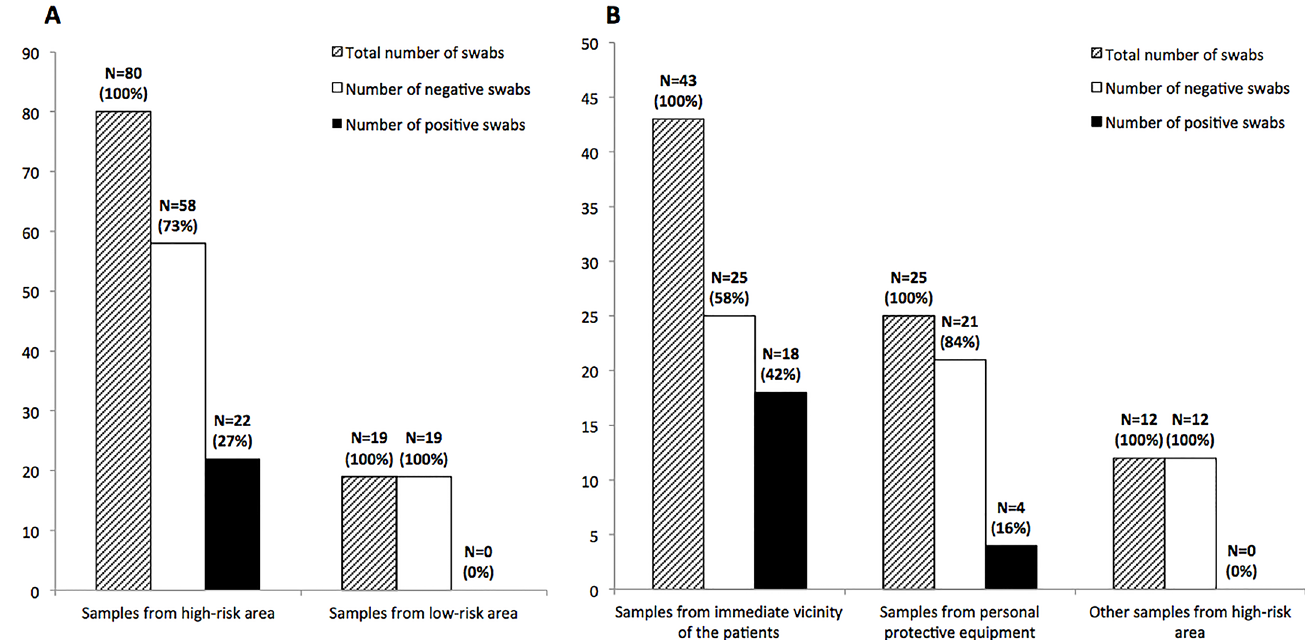
Fig 1. Number of swabs from low- and high-risk areas. A. Number of positive (EBOV RNA+) and negative(EBOV RNA-) swabs from high-risk area. B. Number of positive (EBOV RNA+) and negative (EBOV RNA-) swabs from low-risk area.